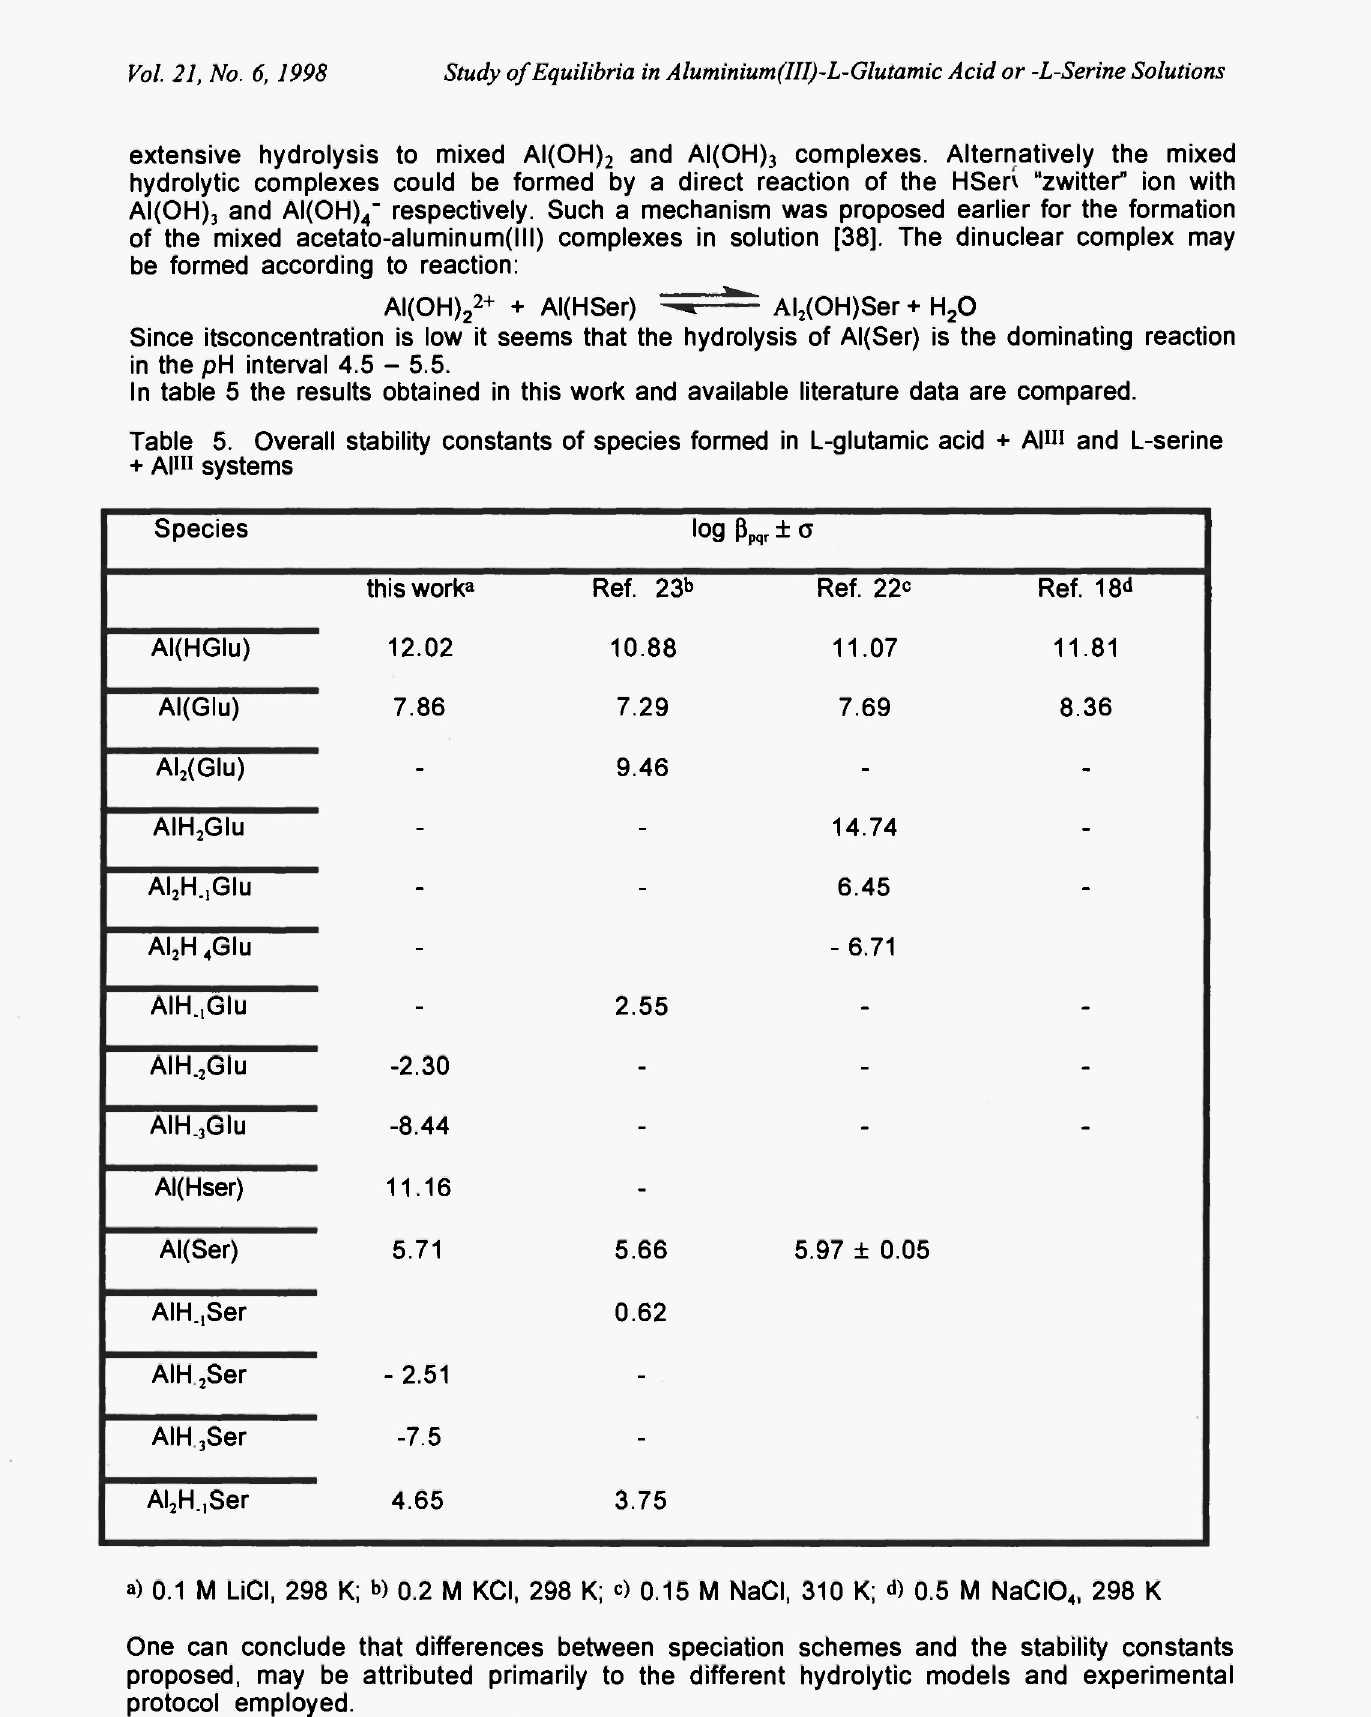
Table 5. Overall stability constants of species formed in L-glutamic acid + Al 1 " and L-serine + Al 111